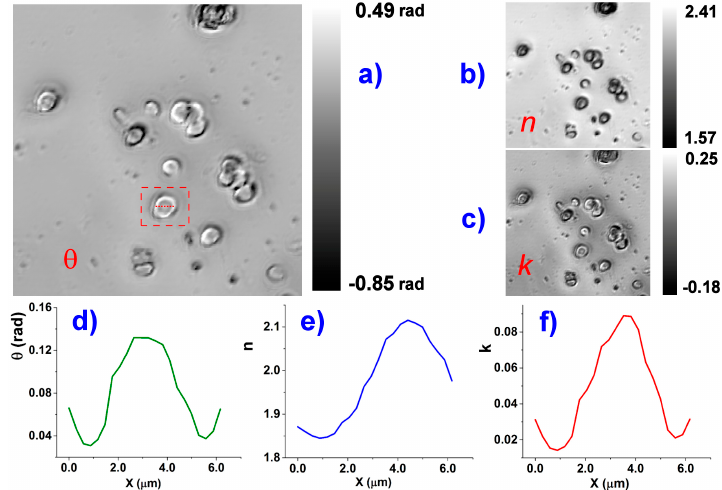
Figure 5. On the left is visible the RBC phase image ( a ); obtained by KK transformation of the HSCM image of Figure 4, at 700 nm. The image appears completely different from the correspondent reflectance image, while it is very similar to an ordinary phase-contrast optical microscopy images; On the right, the correspondent n and k images at 700 nm ( b , c ); The value bars, referred to the respective images, also include in the range image parts where the computed values have no sense, like the substrate or RBC boundaries for which the Fresnel expressions are not valid. An example of local values is given for an RBC marked of the left image: a cross-section is shown for the phase θ ( d ) and the components n and k ( e , f ) of the computed index of refraction. The values, however, have to be interpreted with the aid of the formalism in the text (e.g., see Equation (12)). The full wavelength dependence of n is accessible as a supplemental AVI file.